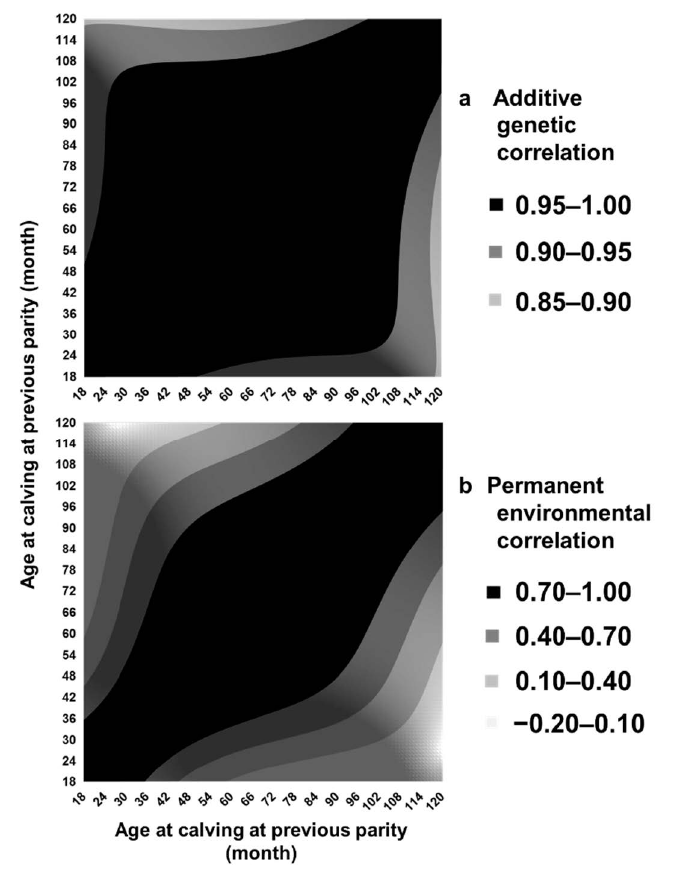
Figure 3. ( a ) Estimated additive genetic correlation and ( b ) permanent environmental correlation among ages of dams at previous calving by the random regression model.